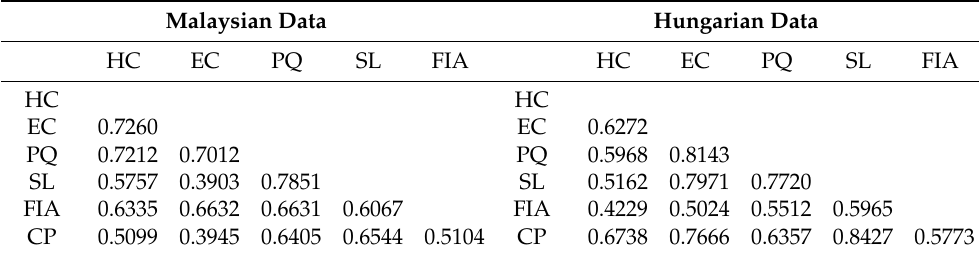
Table 4. The Heterotrait-Monotrait ratio of correlations